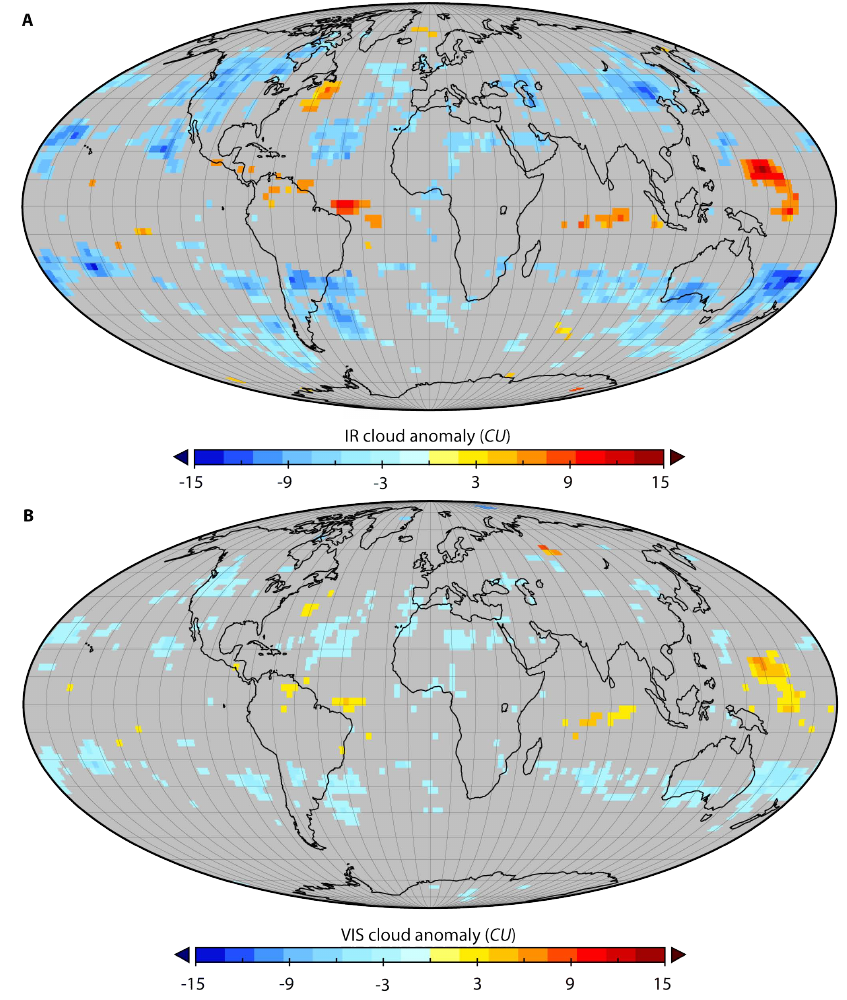
Fig. 3. Anomalous rates of cloud changes (30–1000mb) displayed over the globe for both (A) IR and (B) VIS ISCCP D1 channels; only locally significant (0.95 confidence level) anomalies are